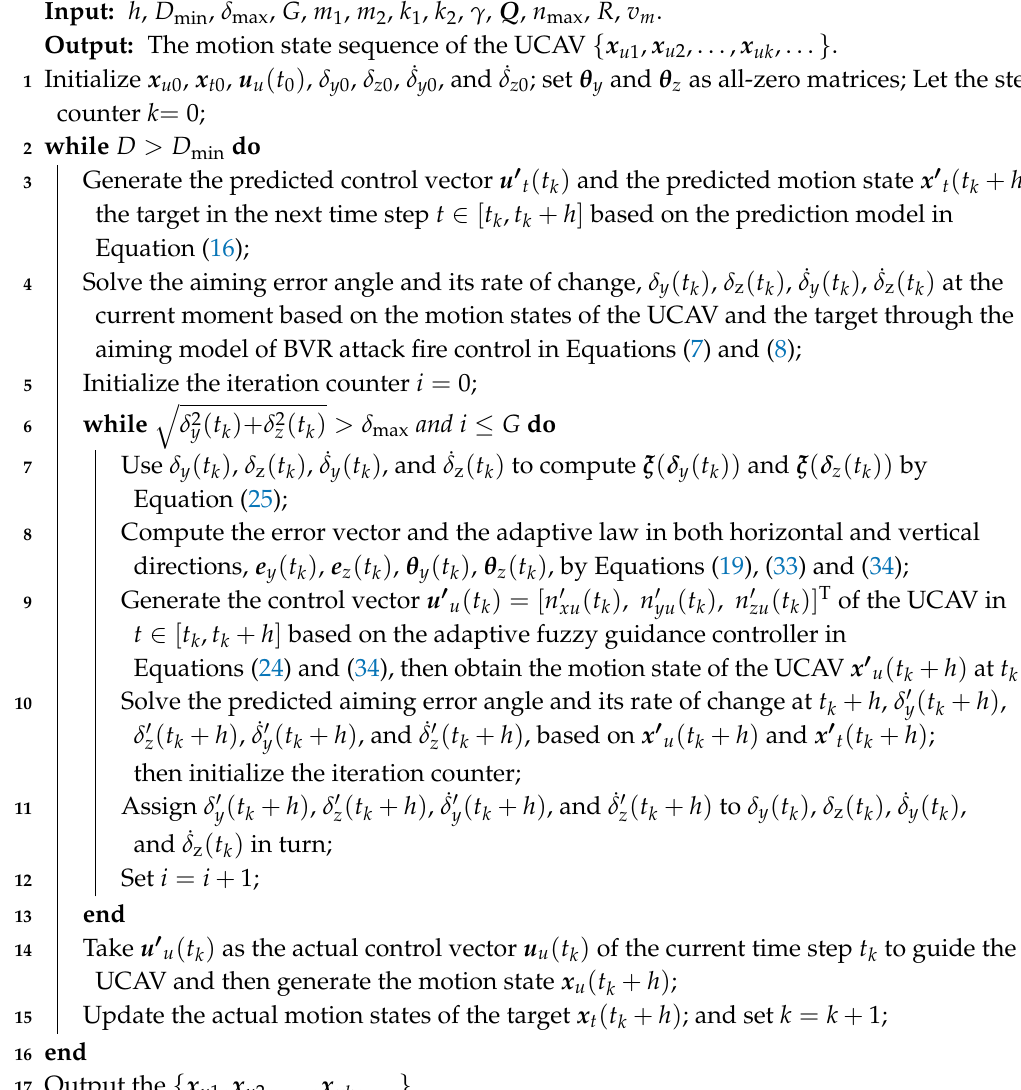
Algorithm 1: The autonomous attack guidance with high aiming